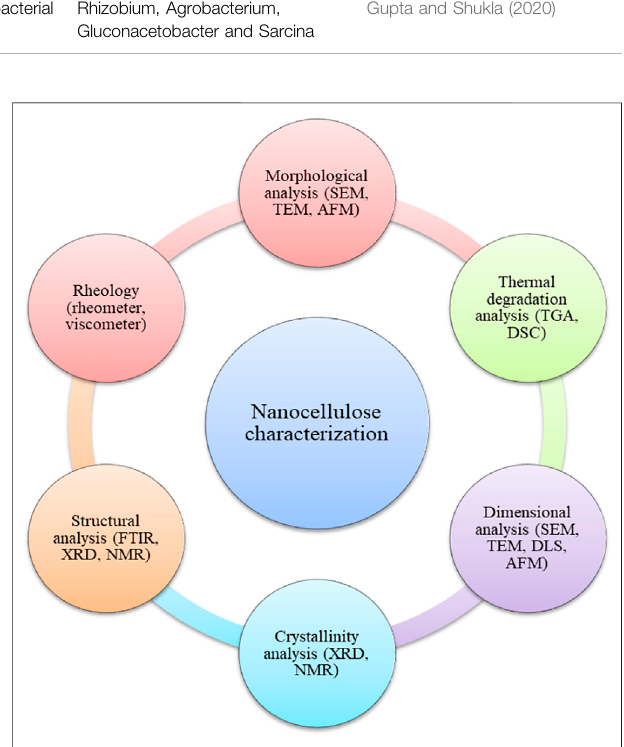
FIGURE 2 | Different techniques for nanocellulose